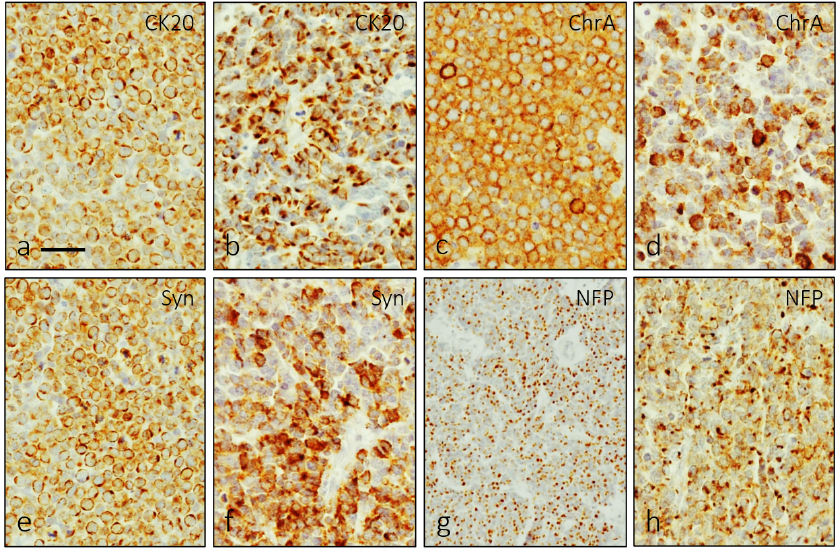
Figure 1. Single immunohistochemistry for CK20 ( a , b ), ChrA ( c , d ), Syn ( e , f ) and NFP ( g , h )